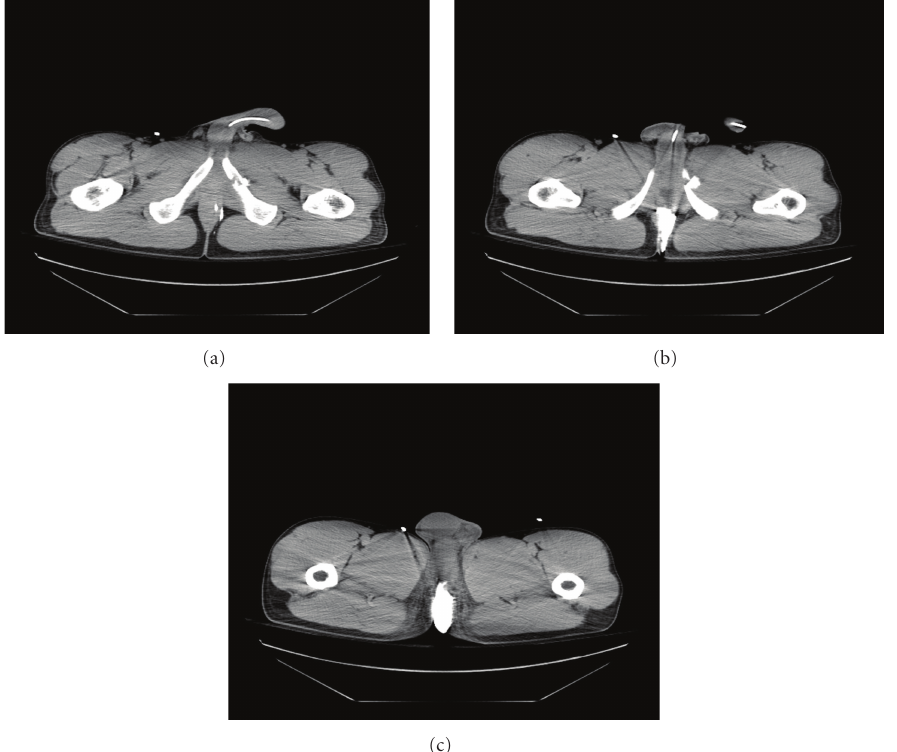
Figure 2: CT Urethrocystography (Siemiens). Contrast fills urethra without filling bladder. Left pubic bone has been detected in (a) and